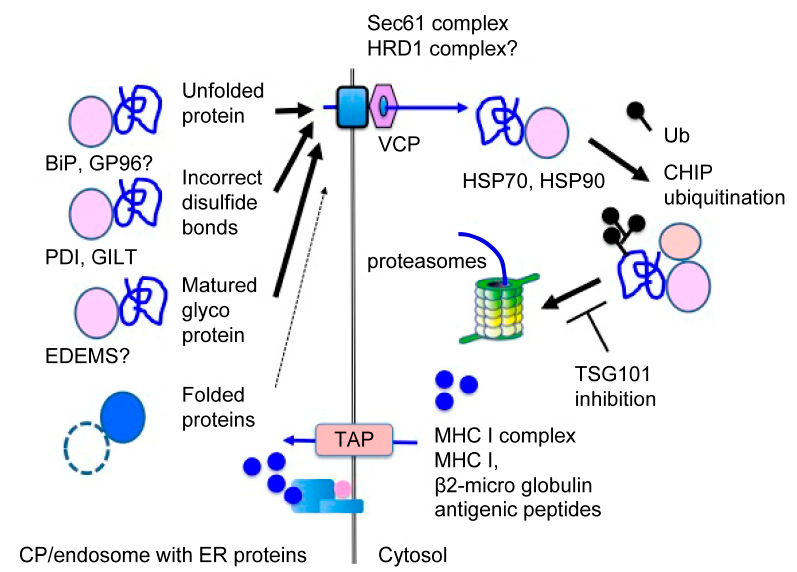
Figure 2. Recognition of extracellular proteins in CP. In ERAD-dependent processing, extracellular proteins are unfolded by ROS, resulting in nonspecific disulfide bonds in endocytic compartments. These unfolded extracellular proteins lose their activity and are preferentially recognized as ERAD substrates by ER-resident molecular chaperones, such as BiP, PDI, or ER-degradation enhancing α -mannosidase-like proteins (EDEMs). After recognition, these proteins are retro-transported into the cytosol. In contrast, self-proteins, which are properly folded in these cellular compartments, are not recognized as ERAD substrates and remain in endocytic compartments. After retro-transportation into the cytosol, extracellular proteins are recognized by cytosolic molecular chaperones, such as Hsp70 or Hsp90. After recognition, extracellular proteins are processed by the ubiquitin-proteasome system (UPS) into antigenic peptides and transported into membranous compartments in a transporter associated with antigen processing (TAP)-dependent manner. These two recognition steps indicate that unfolding and recognition of extracellular proteins are critical for CP.